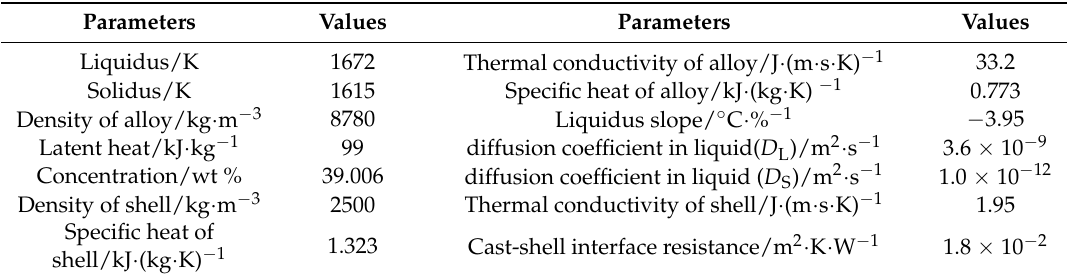
Table 2. Physical parameters in the